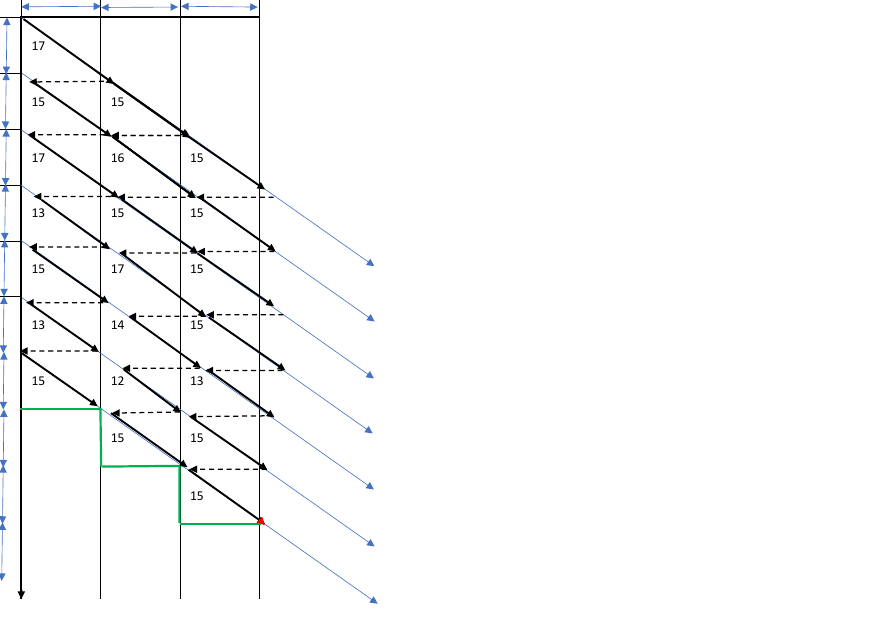
Figure 2. The diagram of employee movement with predicted (C = 15) and real cycle times (12, 13, 14, 15, 17), the product disassembly cycle time is equal to the transport cycle time (TT = 15). When conveyor transport and/or disassembly operations are performed automatically, any disturbance results in suspending one cycle (Figure 3). The disassembly time of a batch of seven products is increased by 15 due to a disturbance of the fourth batch of the product in the second station (red line in Figure 3).